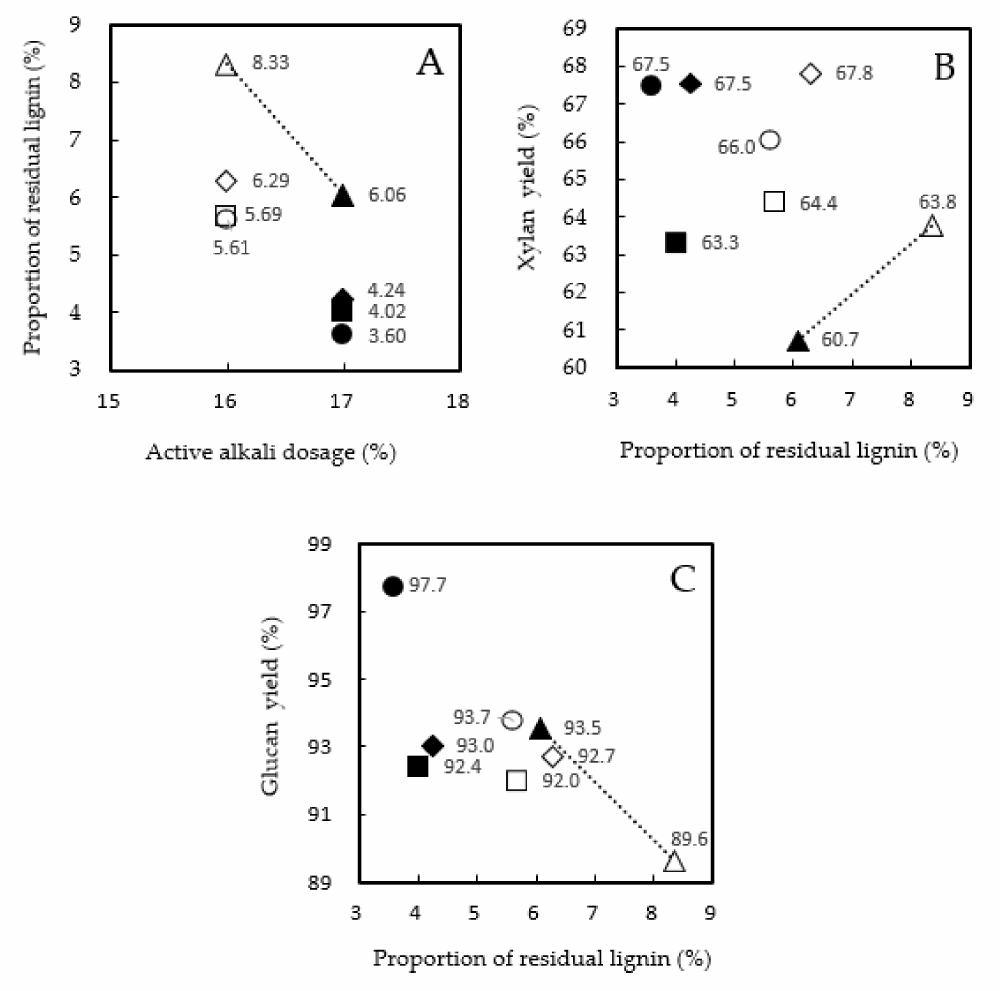
Figure 2. ( A ) Proportion of the residual lignin; ( B ) xylan yield; ( C ) glucan yield in pulps obtained by kraft cooking. • : Myanmar teakwood extracts; (cid:3) : Indonesia teakwood extracts; : 2-methylanthraquinone; (cid:52) : without additives. The (cid:51) white color represents a 16% active alkali dose; the black color represents a 17% active alkali